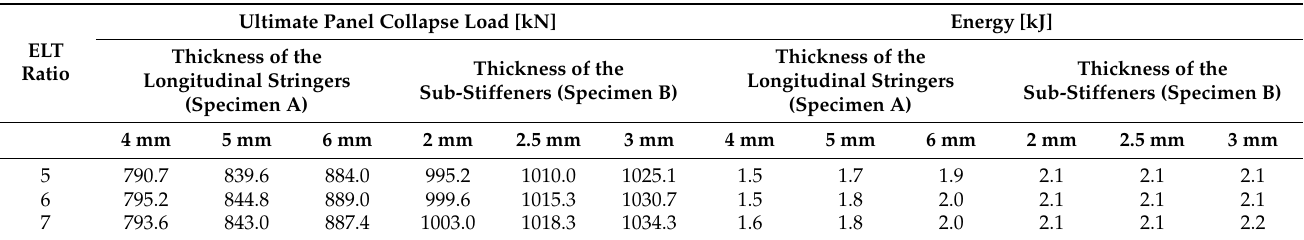
Table 9. Effect of the thickness of stiffeners to ultimate panel collapse